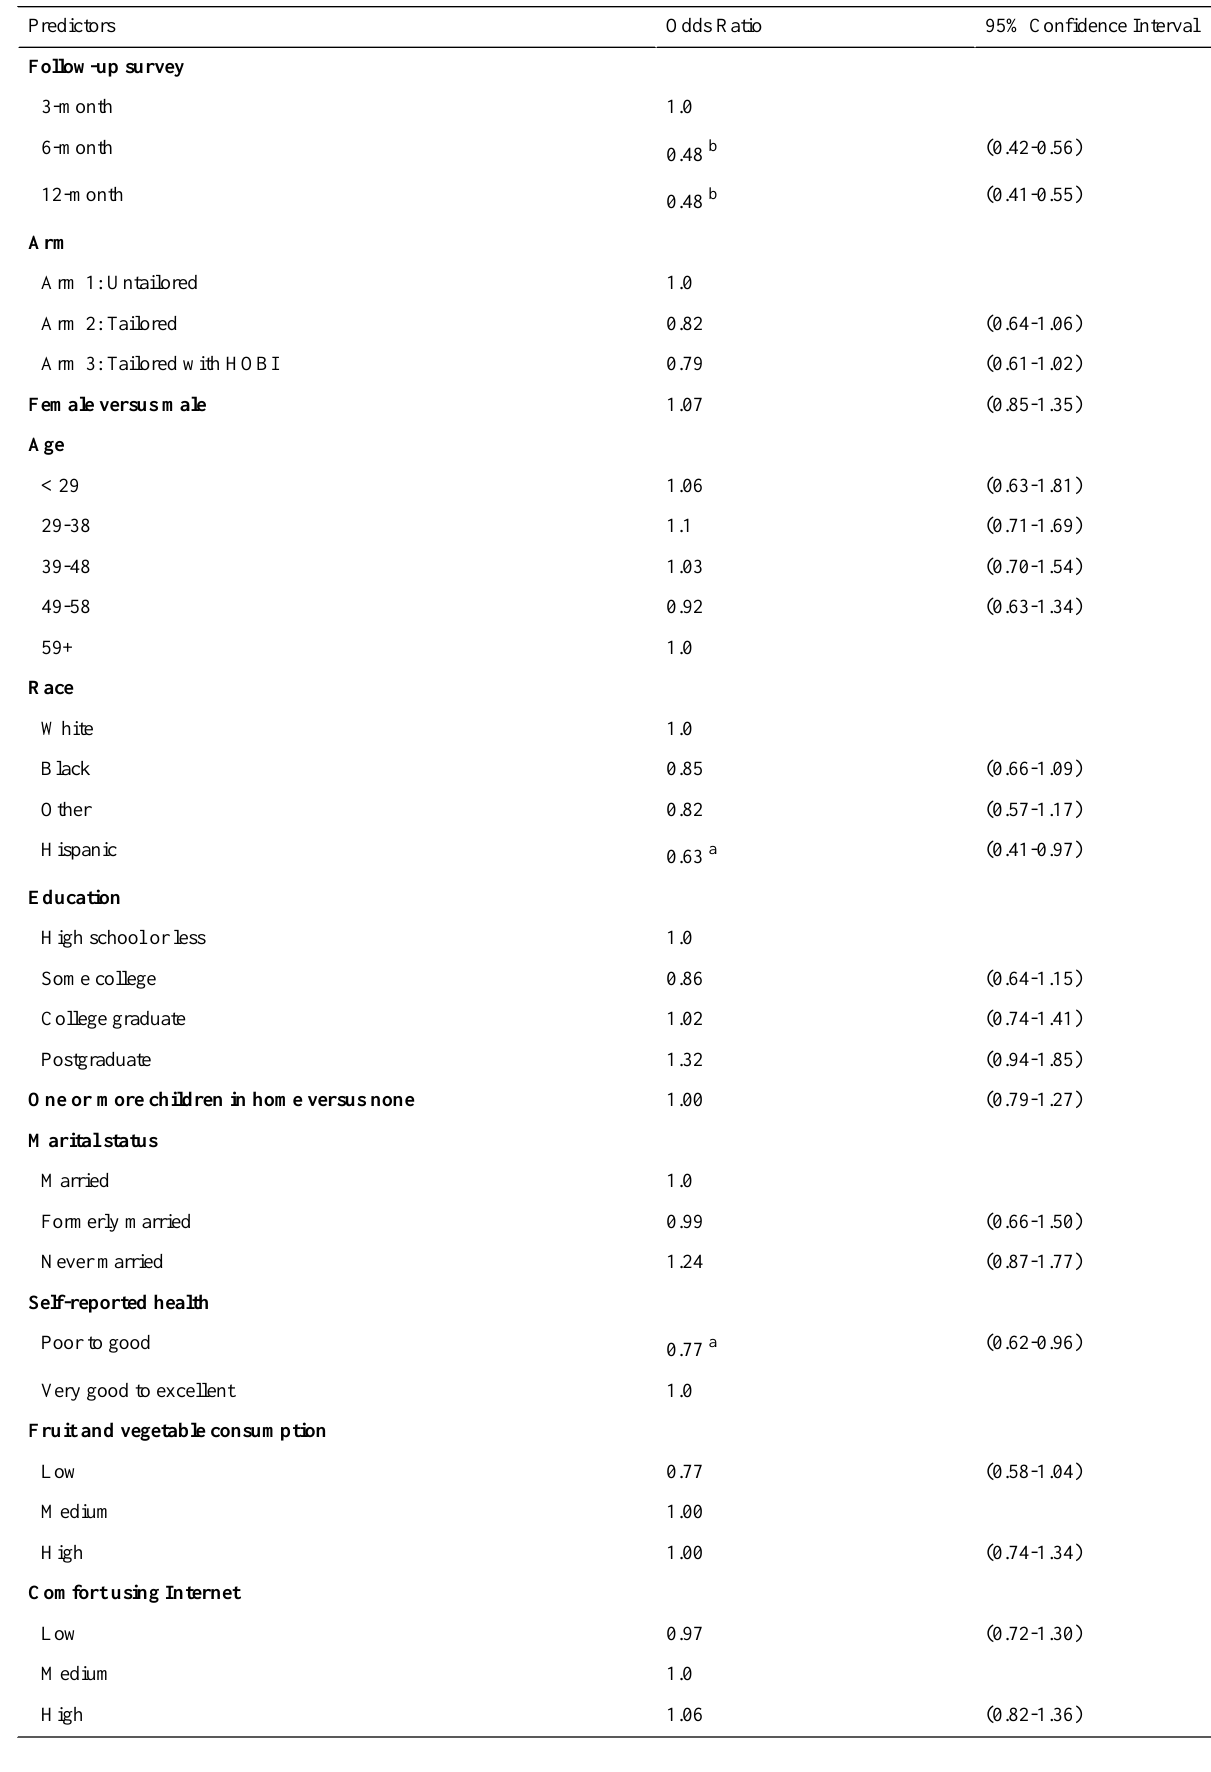
Table 4. Model of survey completion at 3-, 6-, and